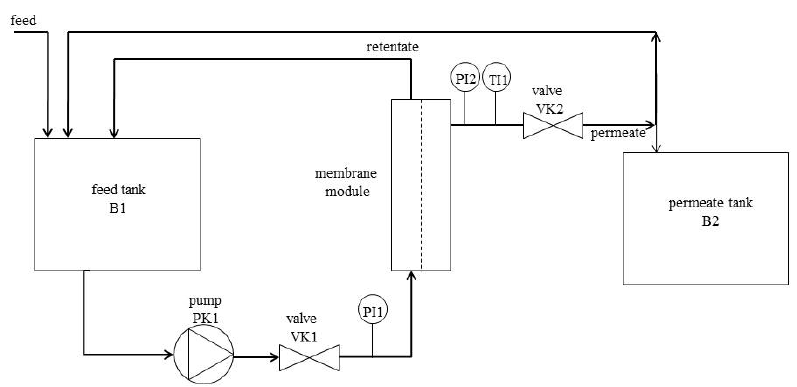
Figure 1. A schematic diagram of the filtration